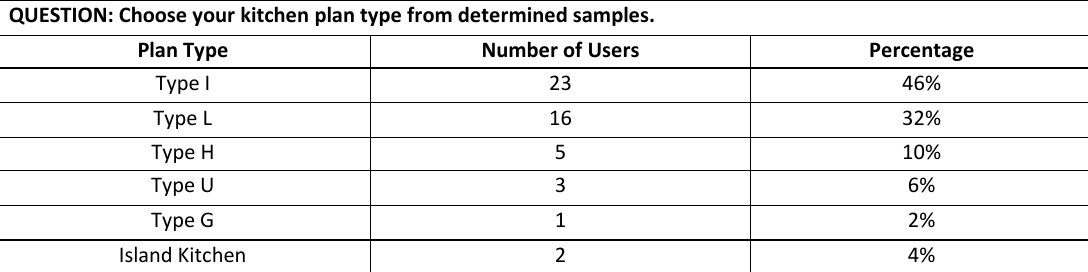
Table 1 Distribution of subjects according to residential kitchen plan type